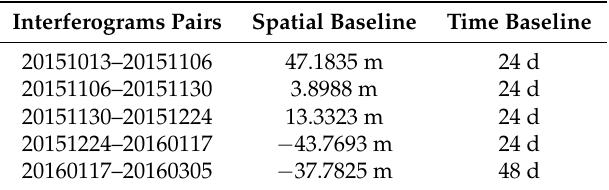
Table 3. Parameters of interferogram pairs.